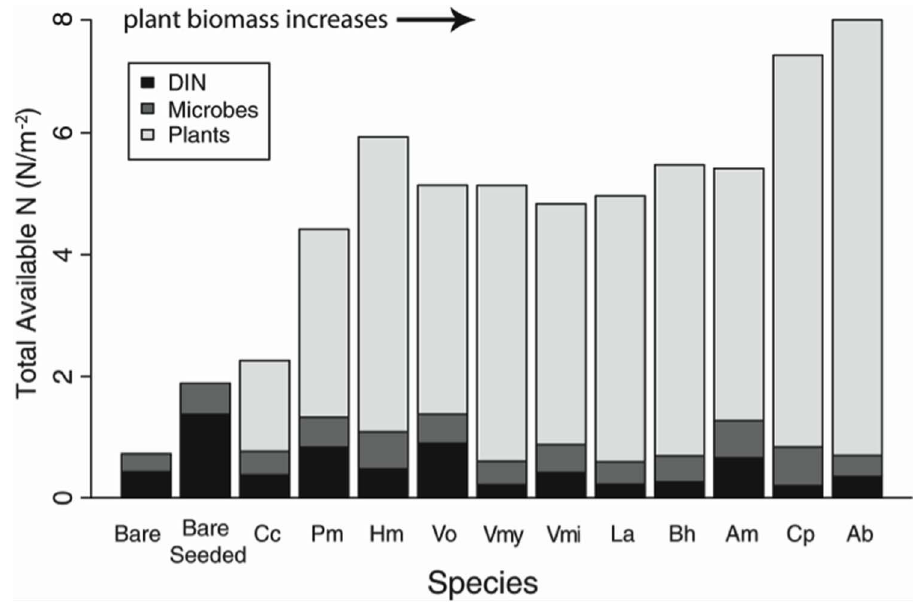
Figure 4. Sum of plant N, microbial N, and final soil DIN to find a total available N in each monoculture plot. Species are listed left to right in order from lowest to highest ranking of aboveground plant biomass in monoculture plots. Kendall’s tau between total available N per m 2 (sum of microbial, plant and soil) and above ground plant biomass is 0.68, 2-sided p=0.001. Species abbreviations are as in Figure 1. (Figs. 3B–D). This is consistent with low soil C:N values, which averaged 7.3 ( 6 0.1), indicating that heterotrophic microbes were